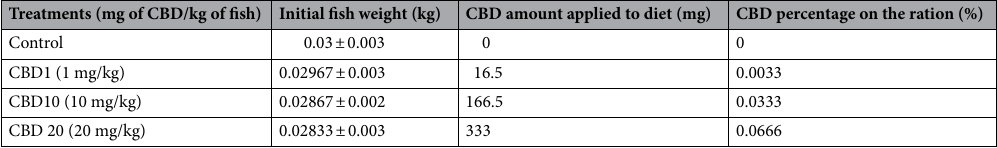
Table 3. General information about the cannabidiol (CBD) amount applied in each treatment diet (2 kg of ration per treatment). The CBD doses of each treatment (0, 1, 10 e 20 mg/kg) were calculated based on initial fish weight. In “Initial fish weight”, values are mean ± SD. CBD cannabidiol.